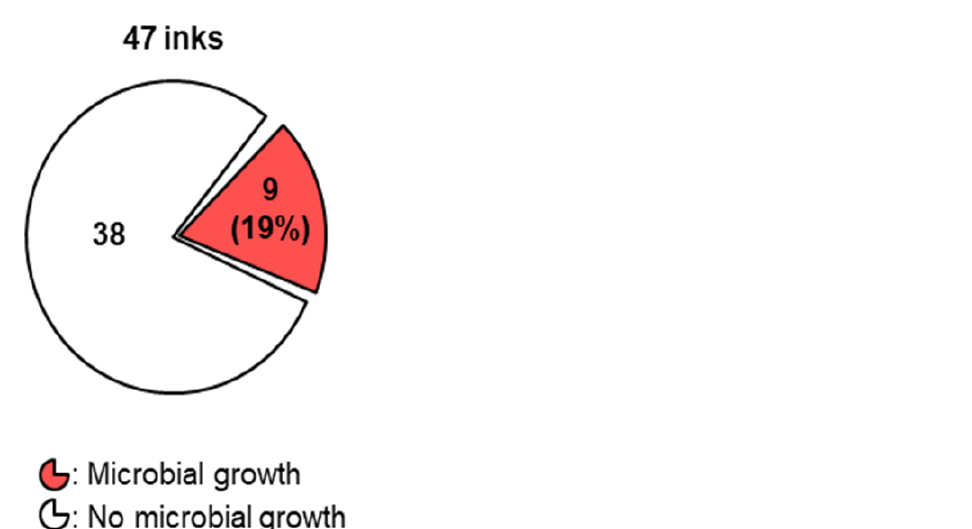
Figure 1. Microbial content of PMU inks. A total of 9 out of 47 PMU inks contained microorgan- isms.